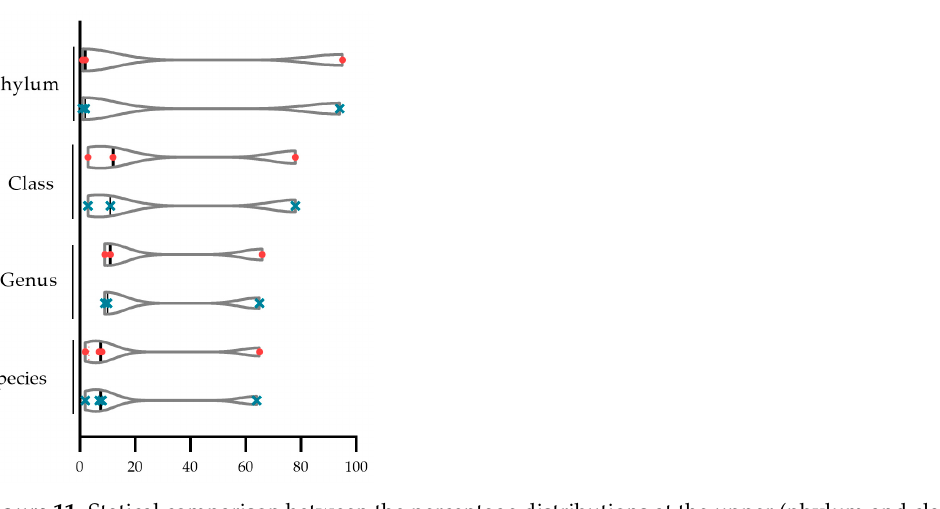
and lower (genus and species) taxonomic levels (Student’s t - and Wilcoxon test with p ≤ 0.05). Red